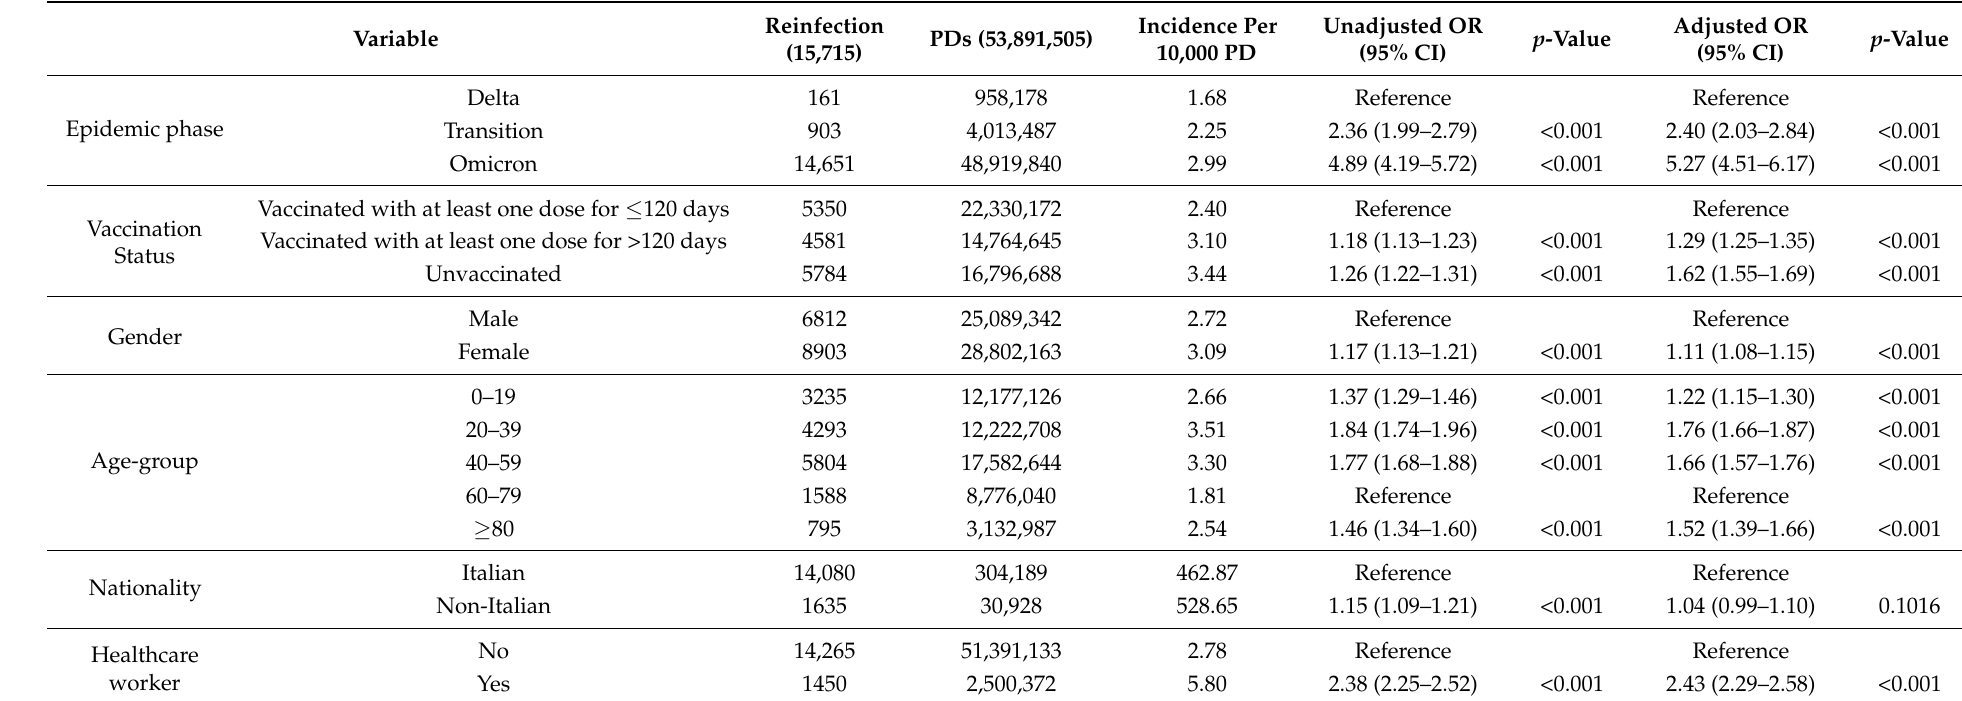
Table 1. Main characteristics and odds ratios of SARS-CoV-2-reinfected individuals in